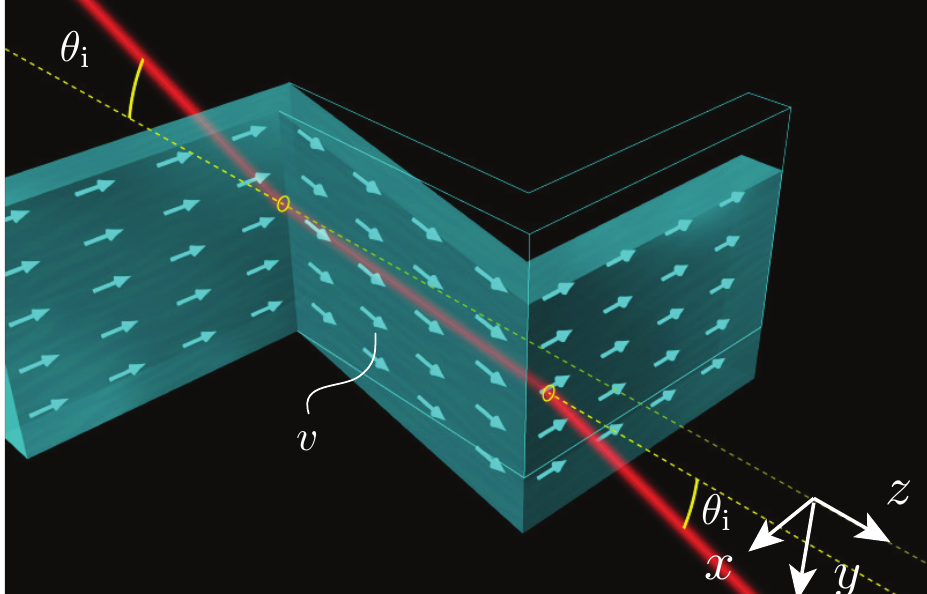
Figure 8. Same as Figure 1, but sheared along the xz plane so as to have the medium moving at an angle with respect to the interface.